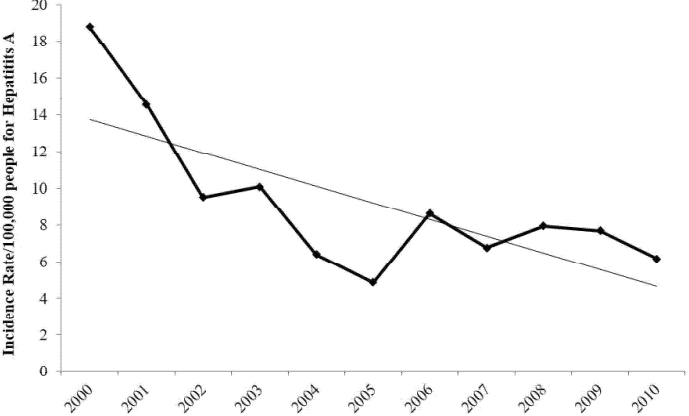
Figure 2. Incidence rate per 100,000 people for hepatitis A in Jordan (2000–2010). Source: Jordanian Ministry of Health data [33].